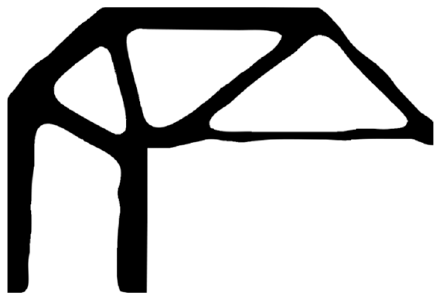
Figure 9. Preliminary optimized shape of C-shaped bracket.